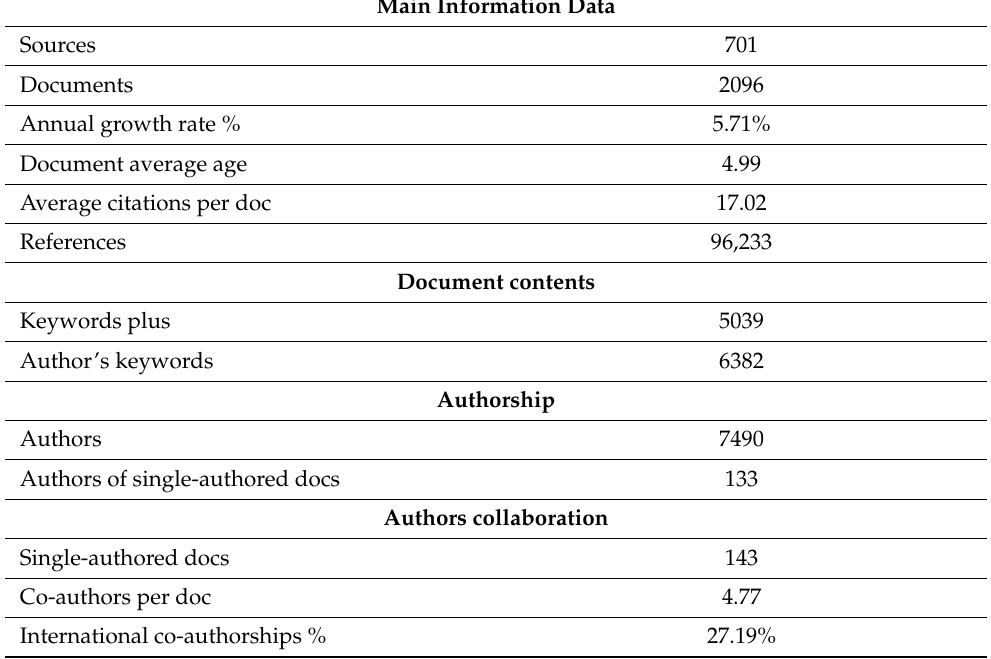
Table 1. Data set